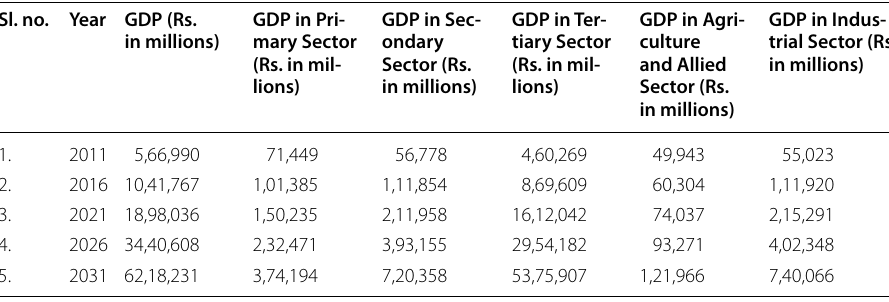
Table 13 Projected GDP, GDP in Primary Sector, GDP in Secondary Sector, GDP in Tertiary Sector, GDP in Agriculture and Allied Sector, and GDP in Industrial Sector Sl. no. Year GDP (Rs. GDP in Pri- GDP in Sec- in millions) mary Sector ondary (Rs. in mil- Sector (Rs. (Rs. in mil- and Allied lions) in millions) lions) Sector (Rs.